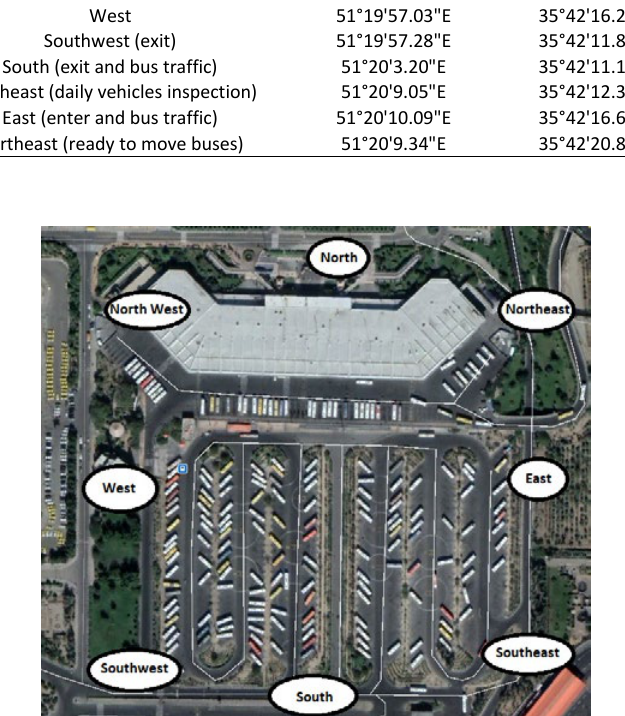
Fig. 3: Locations selected for air pollutants sampling